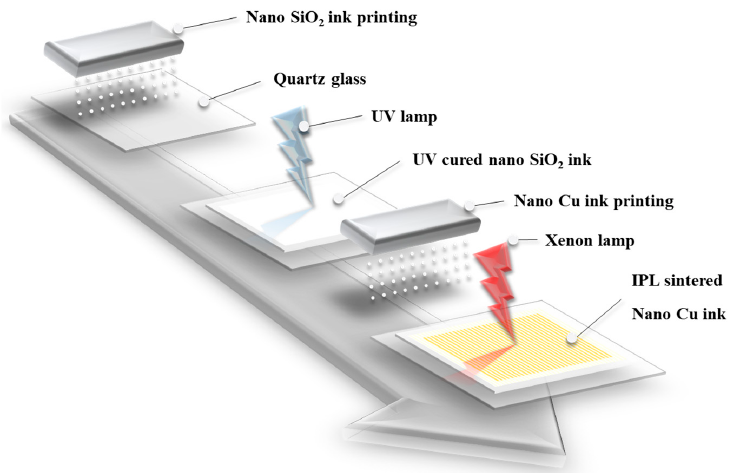
Figure 1. Schematic of ink-jet 3D printing and IPL sintering with photo-cured nano SiO 2 ink and IPL-sinterable nano Cu ink.